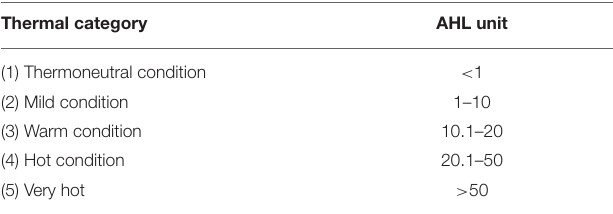
TABLE 4 | Thermal conditions based on accumulated heat load (AHL) values Gaughan et al., 2008. Thermal category AHL